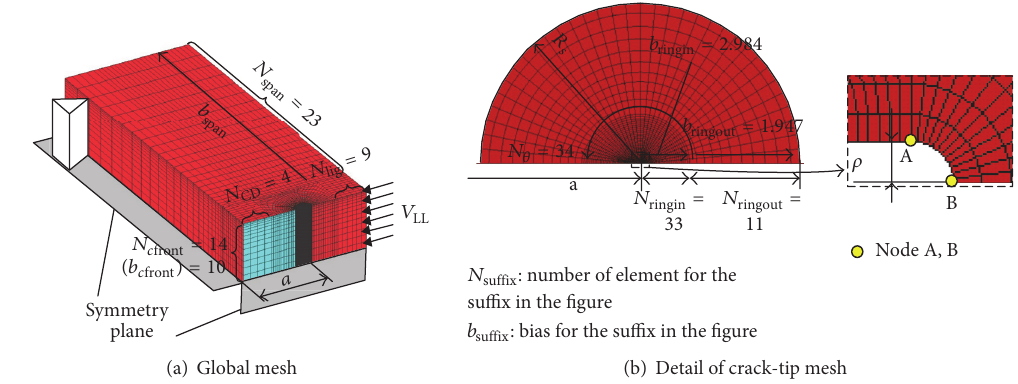
Figure 5: FE model for the SE(B) specimen.